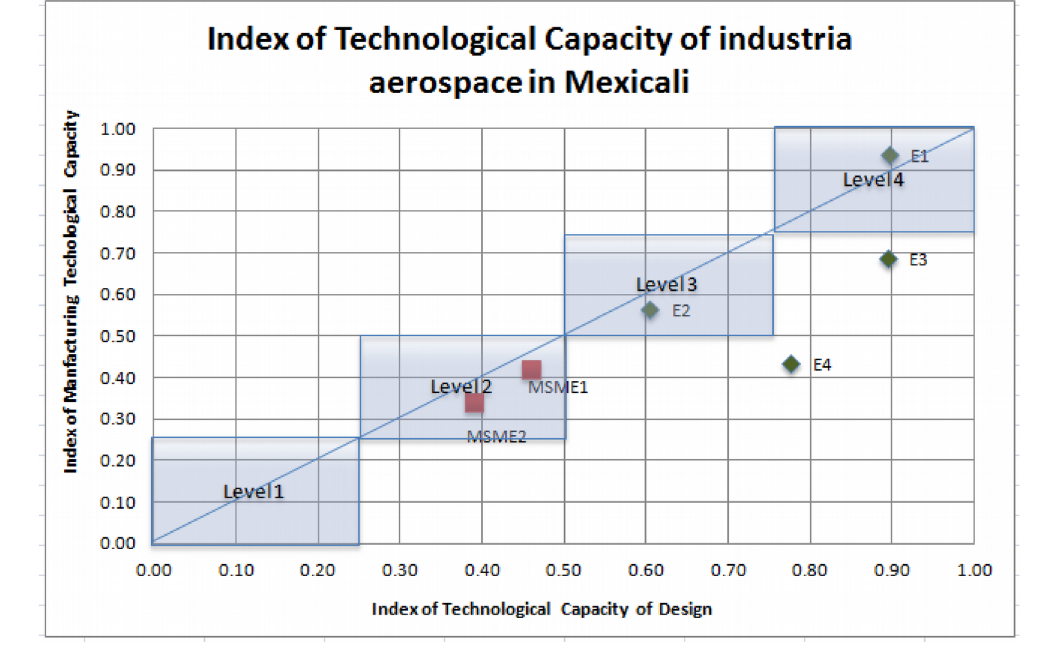
Figure 1. Matrix Technology Capability Indices aerospace